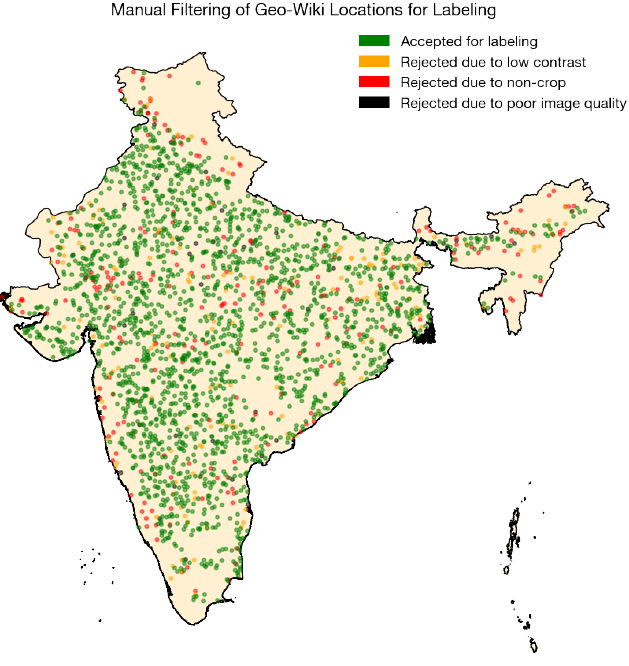
Figure A1. Geographic distribution of locations accepted and rejected for field boundary labeling. The authors inspected 2446 Airbus SPOT images over Geo-Wiki locations and approved 2000 of them for workers to annotate. The reasons for rejecting images were: image was too low contrast for labeling, image contained no crop or very little crop area, and image was low in quality.